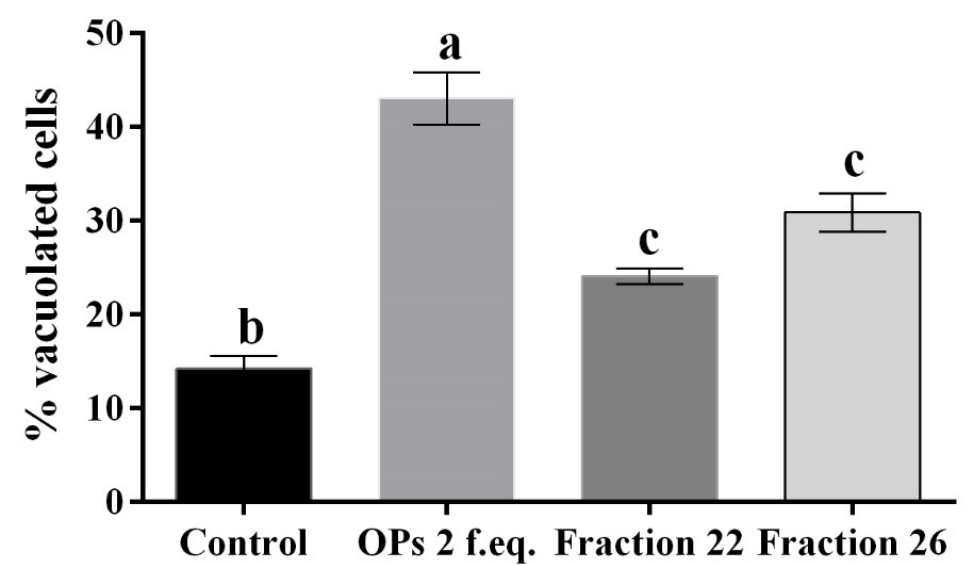
Figure 4. Percentage of vacuolated hemocytes, after treatment with 1X PBS (control), OPs deriving from two equivalent females (2 f. eq.) and HPLC fractions #22 and #26, observed after May–Grunwald–Giemsa staining. Data are reported as means ± SD of n = 3 independent experiments. Statistical analysis was performed with one-way ANOVA and Bonferroni post hoc test. Different letters indicate significant differences ( p value < 0.0001).